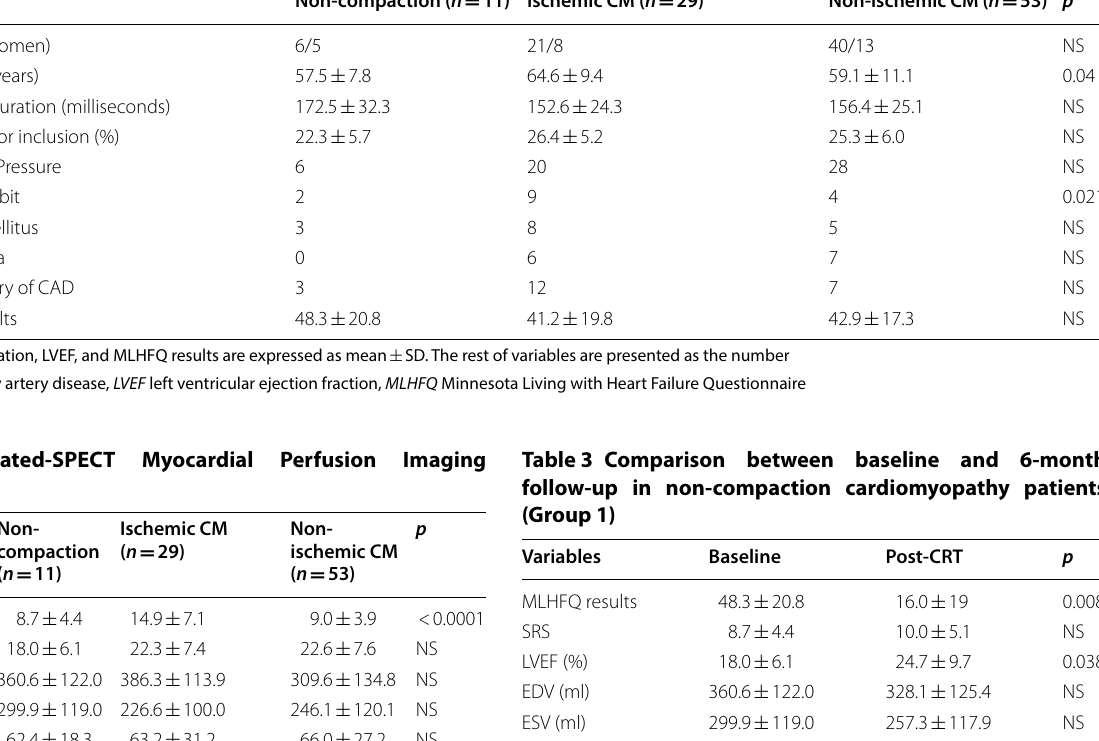
Table 1 Characteristics of Patients